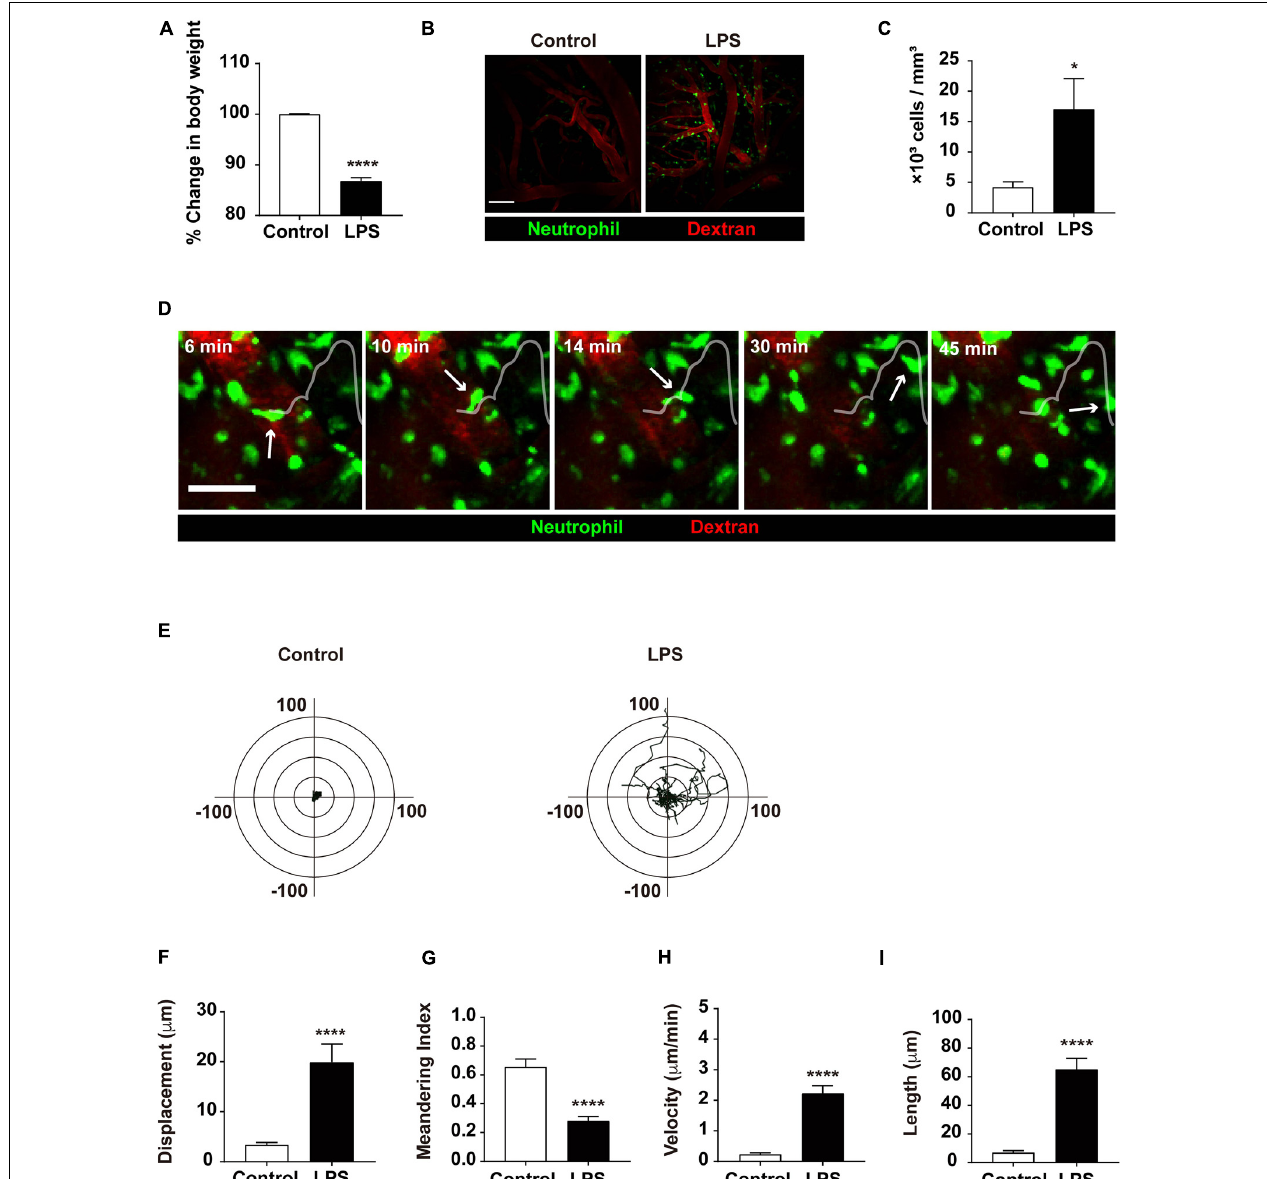
FIGURE 1 | Quantitative analysis of neutrophil infiltration from the blood vessel to brain parenchyma. (A) Representative graph of weight loss in the LPS-treated group compared to the control group. The % change in body weight was calculated as (body weight before LPS treatment/body weight after LPS treatment) × 100. Data indicate mean ± SEM using Student’s t -test (**** p < 0.0001, n = 7 mice per group). (B) LysM GFP / + mice were used to visualize neutrophils (green) via TPIM. Texas red dextran was i.v. injected to stain blood vessels (red). Representative images are shown from the brain of mice injected with PBS (control) or LPS, respectively. Scale bar, 100 µ m (see Supplementary Video 1 ). (C) Measurement of infiltrated neutrophils in the control and LPS groups. Data indicate mean ± SEM using Student’s t -test (* p < 0.05, n = 3 mice per group of three independent experiments). (D) A series of representative time-lapse images show neutrophil infiltration into inflamed brain parenchyma of LysM GFP / + mice. Scale bar, 50 µ m (see Supplementary Video 2 ). (E) Overlay of the representative migration tracks of neutrophils in brain parenchyma for 30 min. x -, y -axis (length), -100 to 100 µ m. n = 30 cells per group, PBS or LPS-treated mice for three independent experiments. Migration was quantitatively assessed with tracking analyses: (F) displacement ( µ m), (G) meandering index (displacement/length), (H) velocity ( µ m/min), and (I) length ( µ m) in two different conditions for 30 min. Data indicate mean ± SEM using Student’s t -test (**** p < 0.0001, n = 30 cells per group of three independent